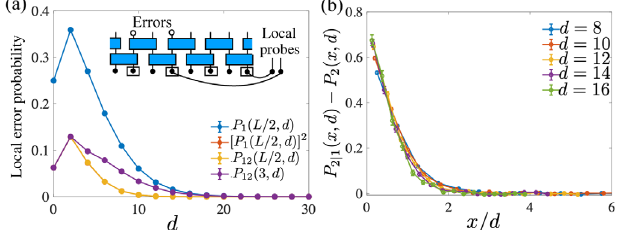
FIG. 6. (a) Local uncorrectable error probability of one P 1 ð x 12 ; d Þ or both P 12 ð x 12 ; d Þ reference probe qubits entangled with the system vs d . Here, we take D ¼ 1 , R ¼ 1 = 2 , 1 = 4 , and N ¼ 128 . Each two-qubit gate in the n =N ¼ e e c ¼ circuit is a random Clifford gate. The local error probability is defined as the probability that the mutual information of a reference qubit is less than maximal after the optimal decoding. Note that the red curve almost perfectly coincides with the yellow curve, indicating an absence of connected correlations for these far-separated uncorrectable errors. (b) Conditional error proba- bility of probe 2 when an error affects probe 1 vs scaled distance for different d . When a probe fails in a given region, it implies that the second probe at a distance on the order of d also fails with high